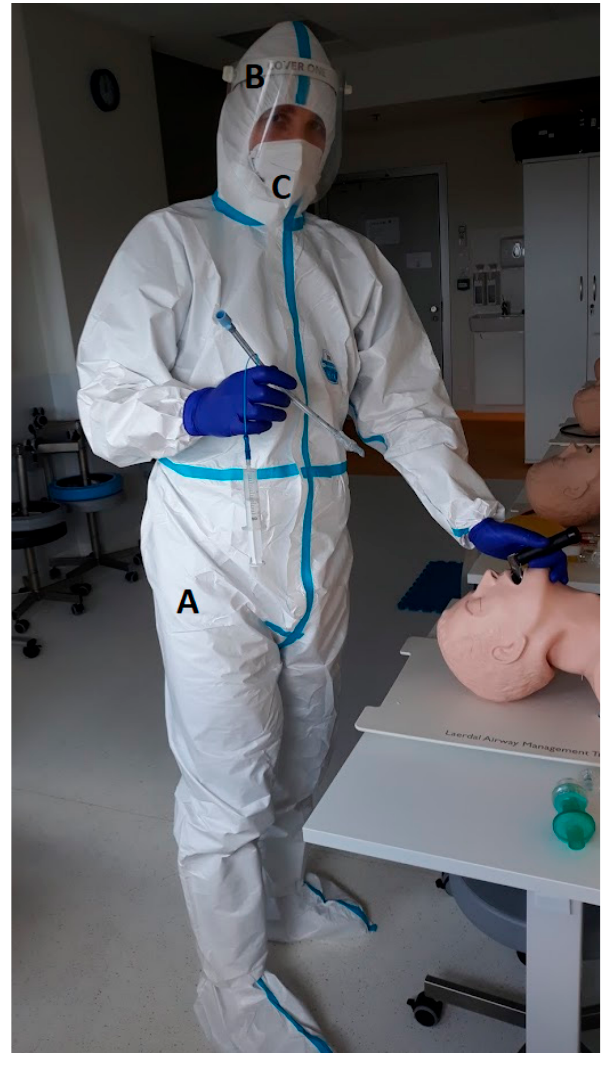
Figure 2. PPE-AGP used in the study— A : medical protective clothing; B : face shield; C : disposable FFP2 mask.